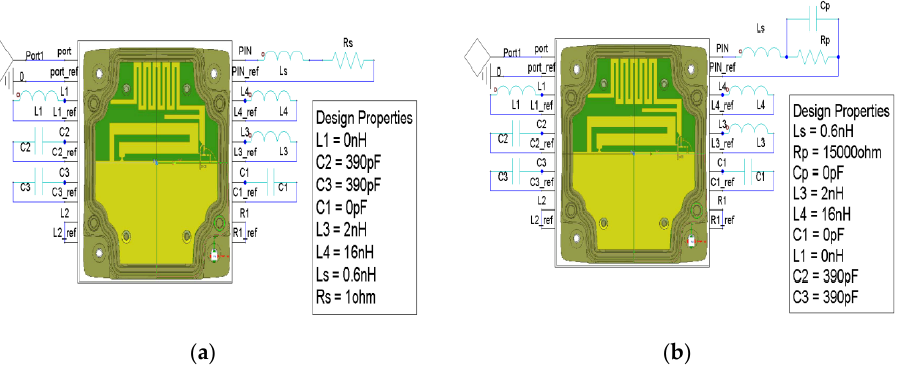
Figure 3. Schematic of the EM circuit co-simulation (HFSS) of the modeled antenna within enclosure, the PIN diode and the loaded lumped components: ( a ) PIN diode equivalent in ON state; ( b ) PIN diode equivalent model in OFF state.